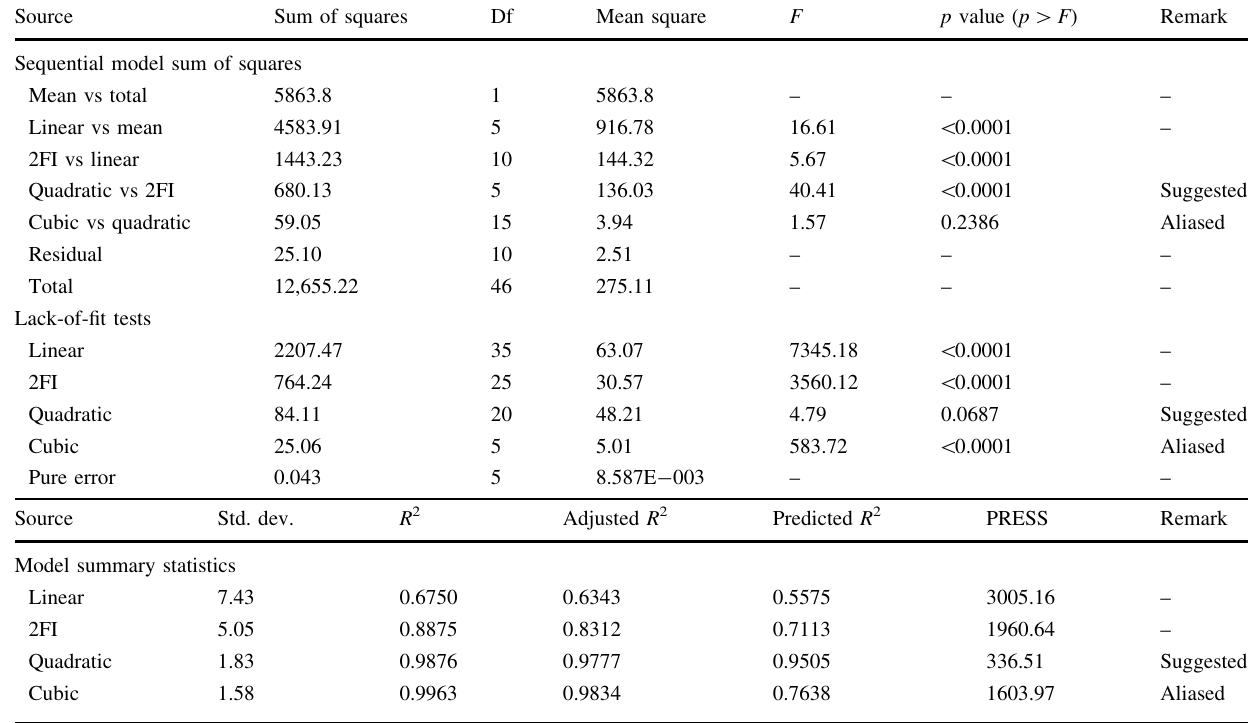
Table 5 Adequacy of the model tested for MPKSF–As design